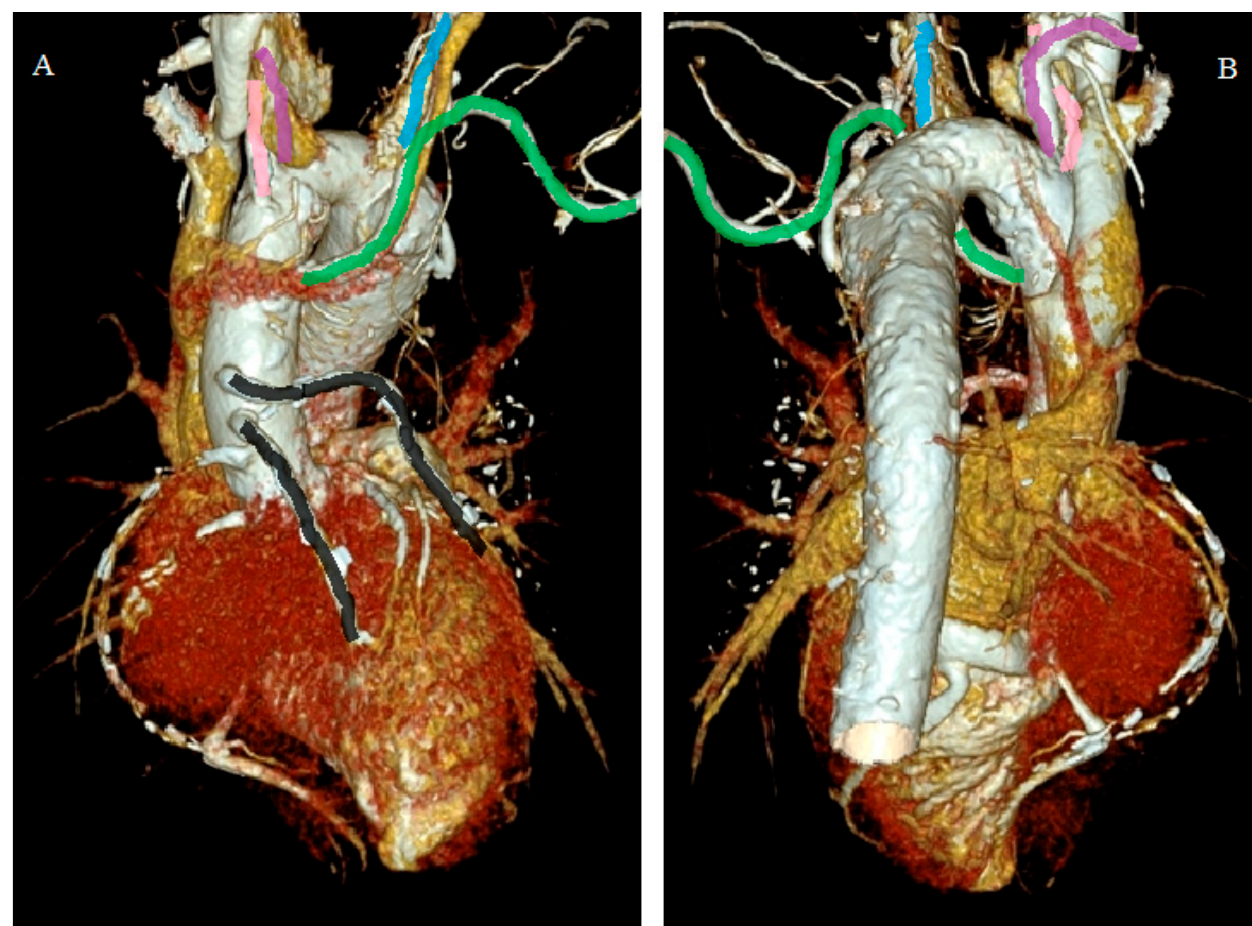
Figure 4. The right aortic arch and its branches. ( A ) Coronal anterior view. ( B ) Coronal posterior view. Discussion: A right aortic arch is a developmental variant of the aortic arch in